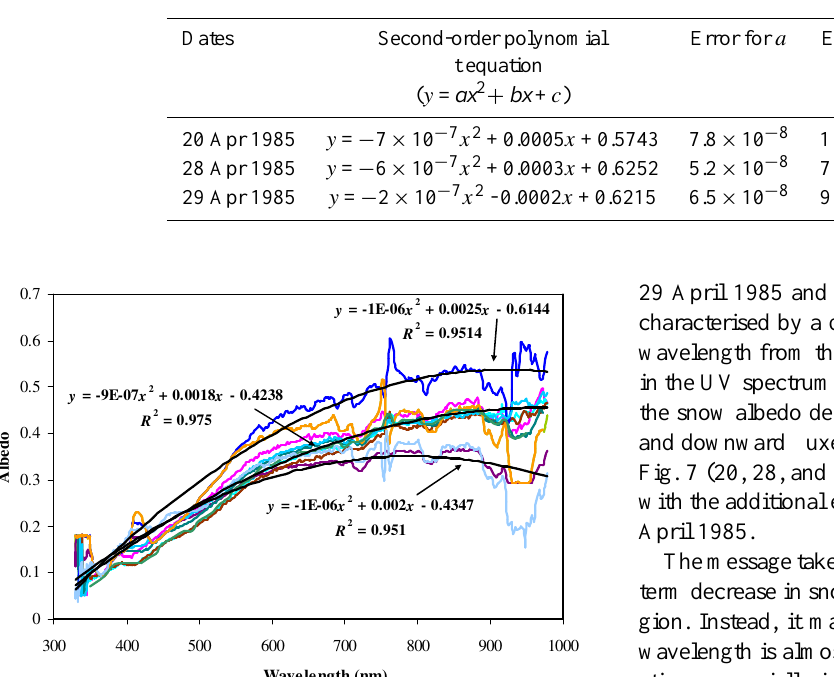
Table 7. Dates and fit equations along with the errors of the coefficients for snow albedo shown in Fig. 9. All given a , b , and c values are statistically significant at the 95% confidence interval.